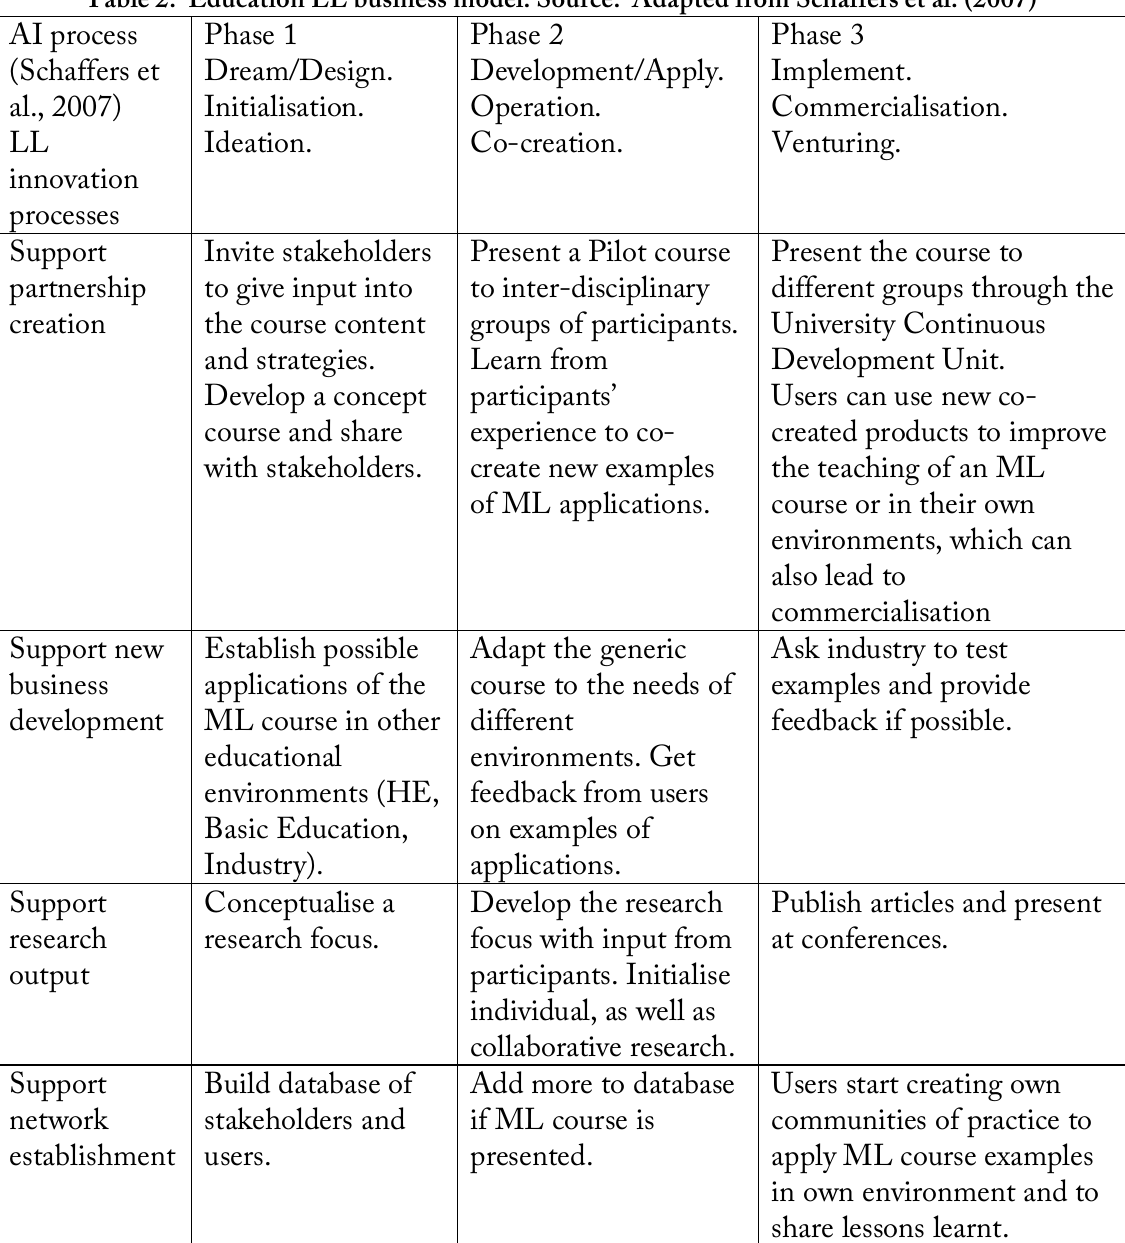
Table 2: Education LL business model. Source: Adapted from Schaffers et al.